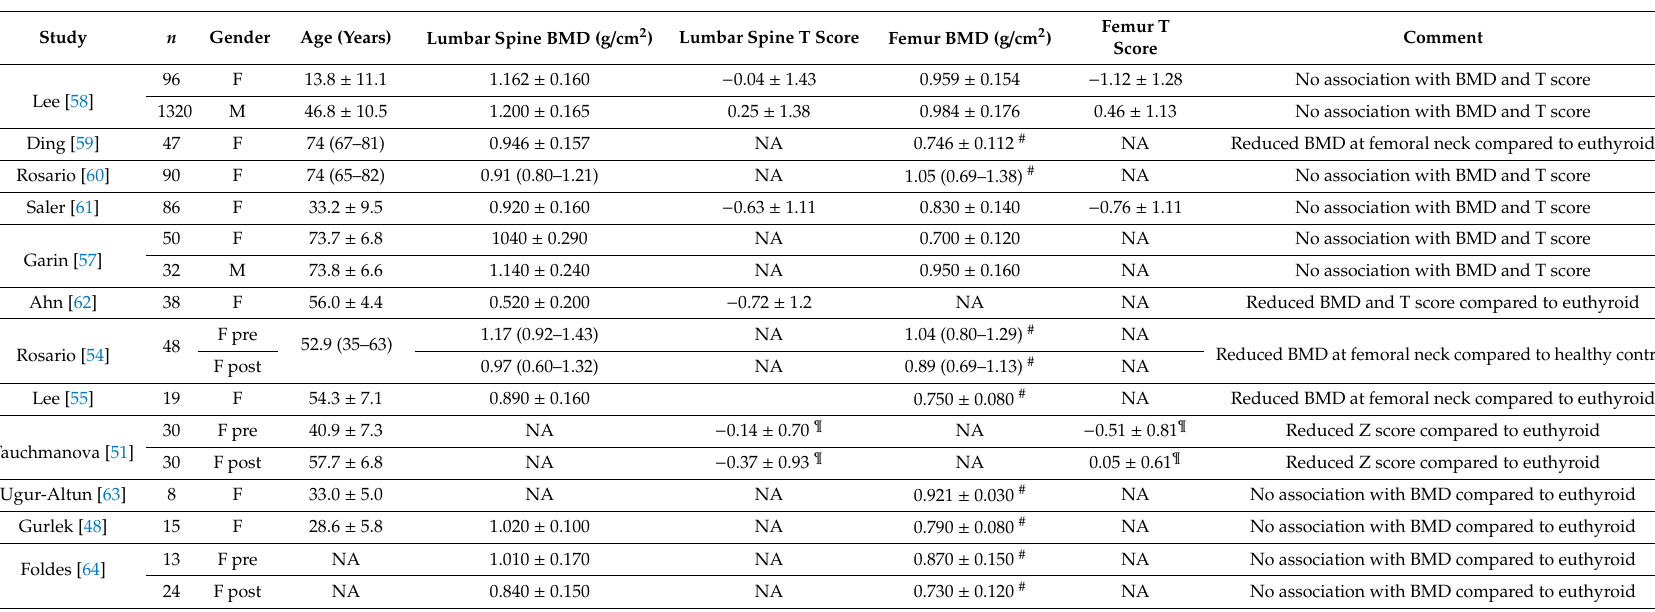
Table 2. Studies that analyzed the e ff ect of endogenous subclinical hyperthyroidism on lumbar spine bone mass density and femoral bone mass